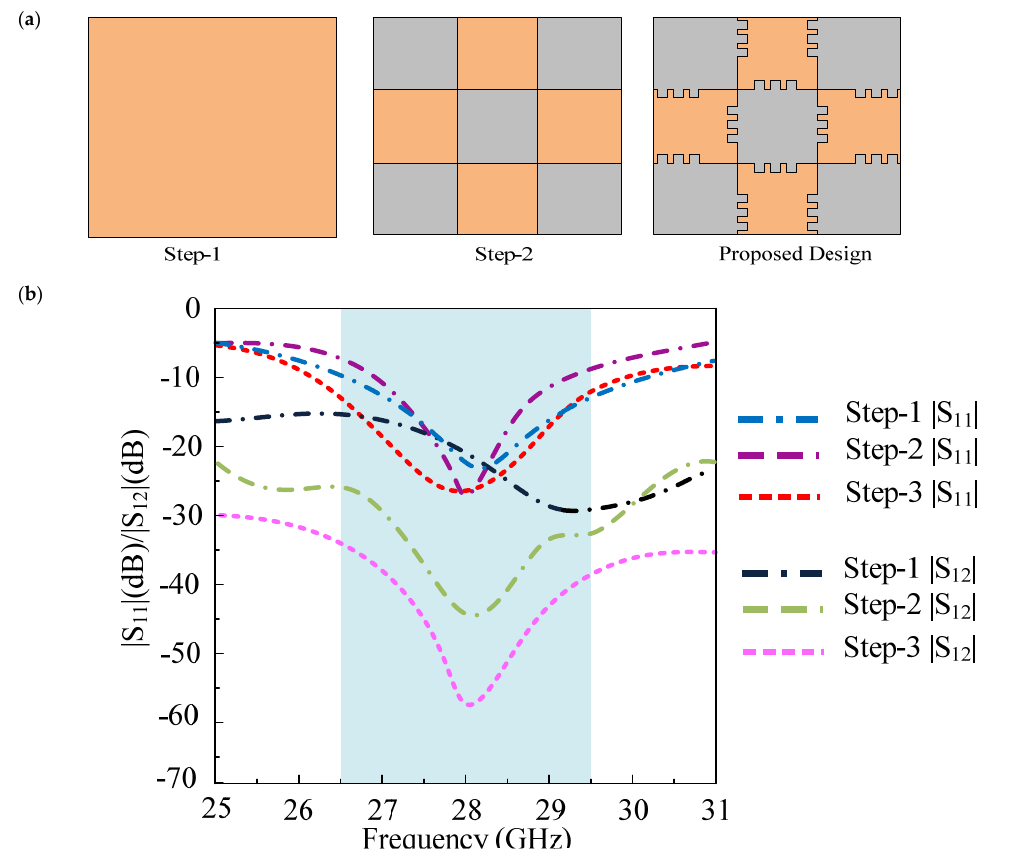
Figure 7. MIMO antenna: ( a ) with its design stages and ( b ) the transmission and reflection coefficients.